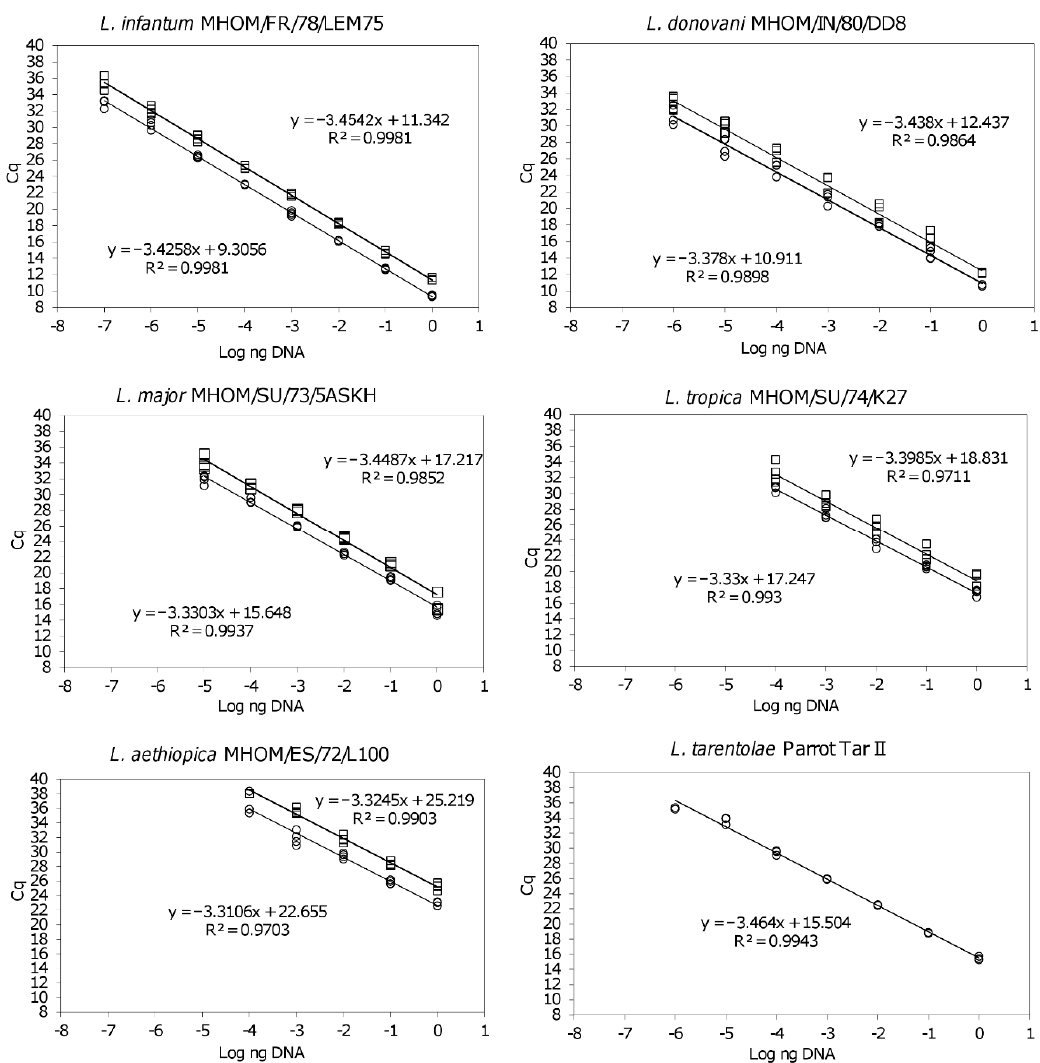
Figure 1. qPCR-ML standard curves obtained from DNA serial dilutions of L. ( L .) infantum MHOM/FR/78/LEM75, L. ( L .) donovani MHOM/IN/80/DD8, L. ( L .) major MHOM/SU/73/5ASKH, L. ( L .) tropica MHOM/SU/74/K27, L. ( L .) aethiopica MHOM/ET/72/L100, L. (S.) tarentolae Parrot Tar II. The standard curves were spiked (upper curve, square points) or non-spiked (lower curve, circle points) with 30 ng human DNA. The standard curve of L. (S.) tarentolae Parrot Tar II, not pathogenic to humans, was not spiked. Each point derived from a duplicate of two independent experiments. The variability of kDNA minicircle target sequence was investigated among 11 L. ( L .) infantum strains by amplification of 0.02 ng promastigote DNA. Dunn’s post-test analysis of Cq values revealed significant differences among V2921 clinical isolate, MHOM/IT/86/ISS218 strain and clinical isolate 10816 (Figure 2). The average Cq was 19.36 ± 1.14, very close to the value obtained for the strain MHOM/FR/78/LEM75 (19.44 ± 0.56), suggesting that this strain could be used as reference to obtain approximate quantification values for illness caused by L. ( L .) infantum .